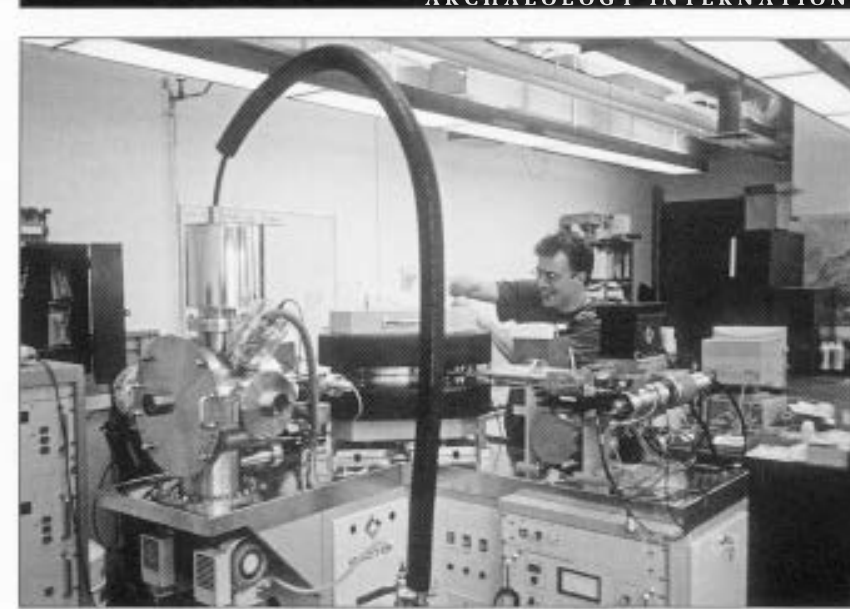
A thermal-ionization mass spectrometer. The sample filaments are loaded into the instrument through the door on the right; the ions are directed through the flight tube through electric and magnetic fields, and are counted by detectors at the other end on the right. seasonally to exploit wild foods - two alternate explanations for a non-local iso­ tope signature at a site. In the analytical procedure that I follow, several milligrams of tooth enamel from an